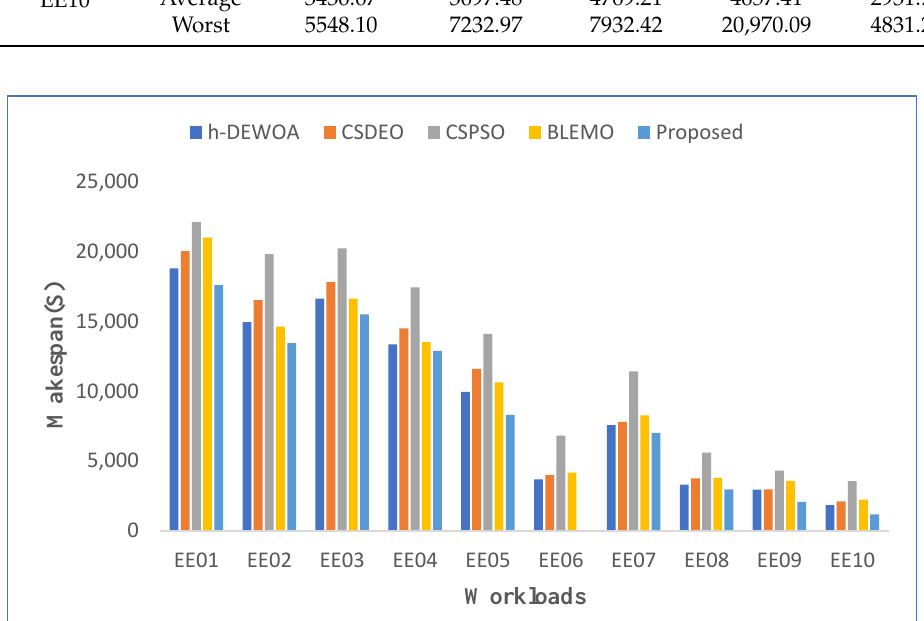
Figure 6. Best makespan result for HPC2N workload.